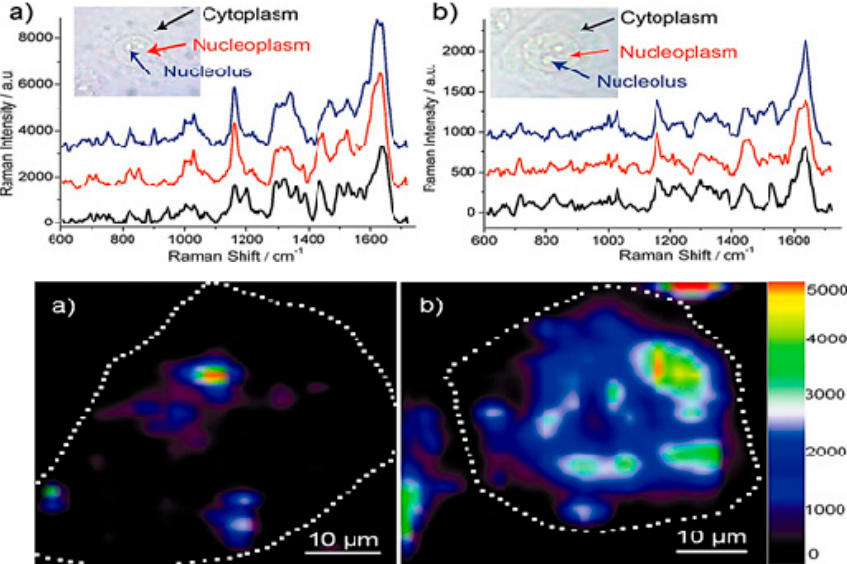
Figure 13. In the upper ( a ) GO/PVP/IGAuNPs and ( b ) IGAuNPs—SERS spectra of A549 cells collected from the regions corresponding to the cytoplasm, nucleoplasm, and nucleolus. In the lower—typical SERS images of A549 cells contained with ( a ) IGAuNPs or ( b ) GO/PVP/IGAuNPs, showing the distribution of gold nanostructures inside the cell. The dotted lines in the images are drawn to indicate the boundaries of select cells. Adapted from [220], with permission from ©2012 American Chemical Society. Materials 2016 , 9 , x